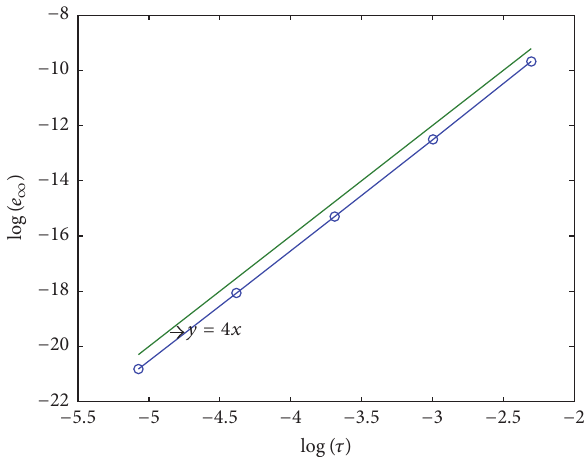
Figure 1: Fourth-order accuracy analysis in time for ℎ = 0.0156 and 𝜏 = 1/160, 1/80,1/40, 1/20 , and